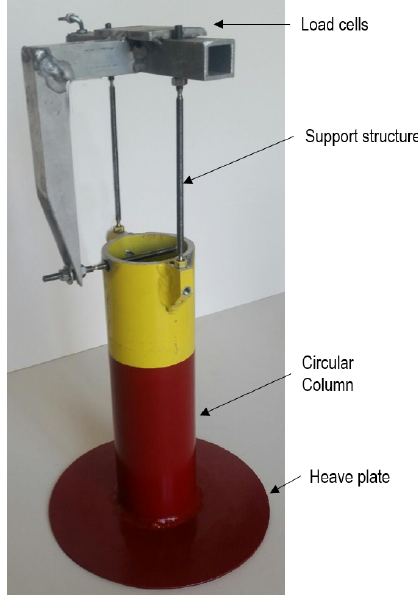
Figure 3. Column with a circular heave plate attached to a frame.